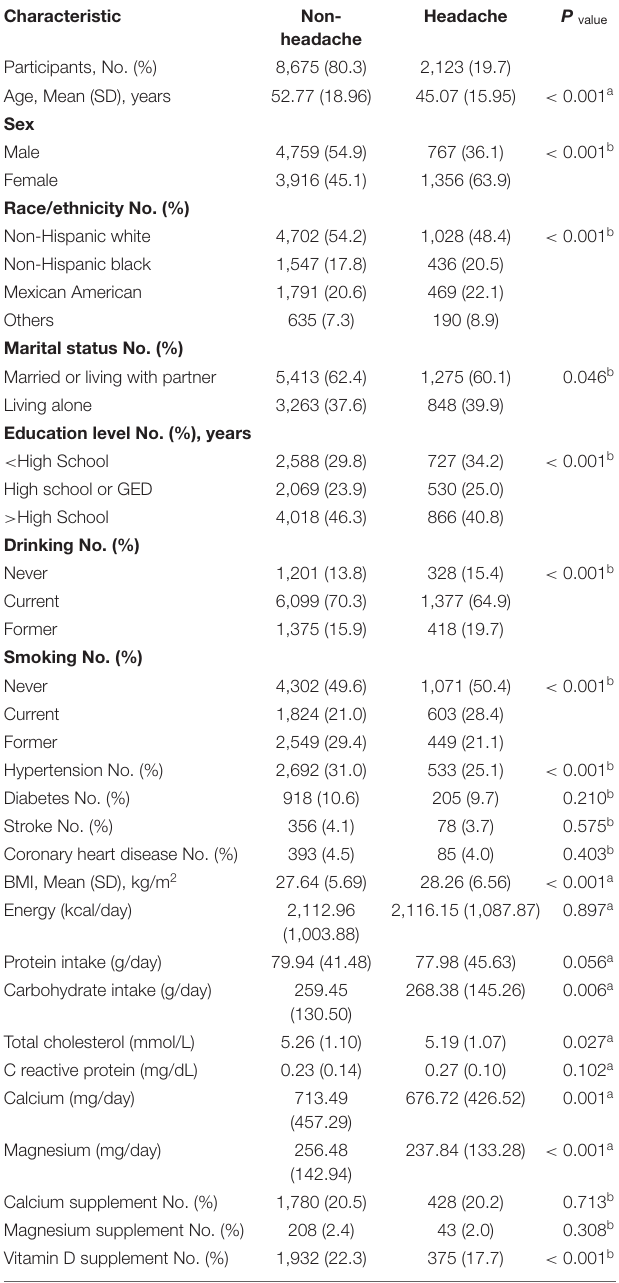
TABLE 1 | Characteristics of participants with or without